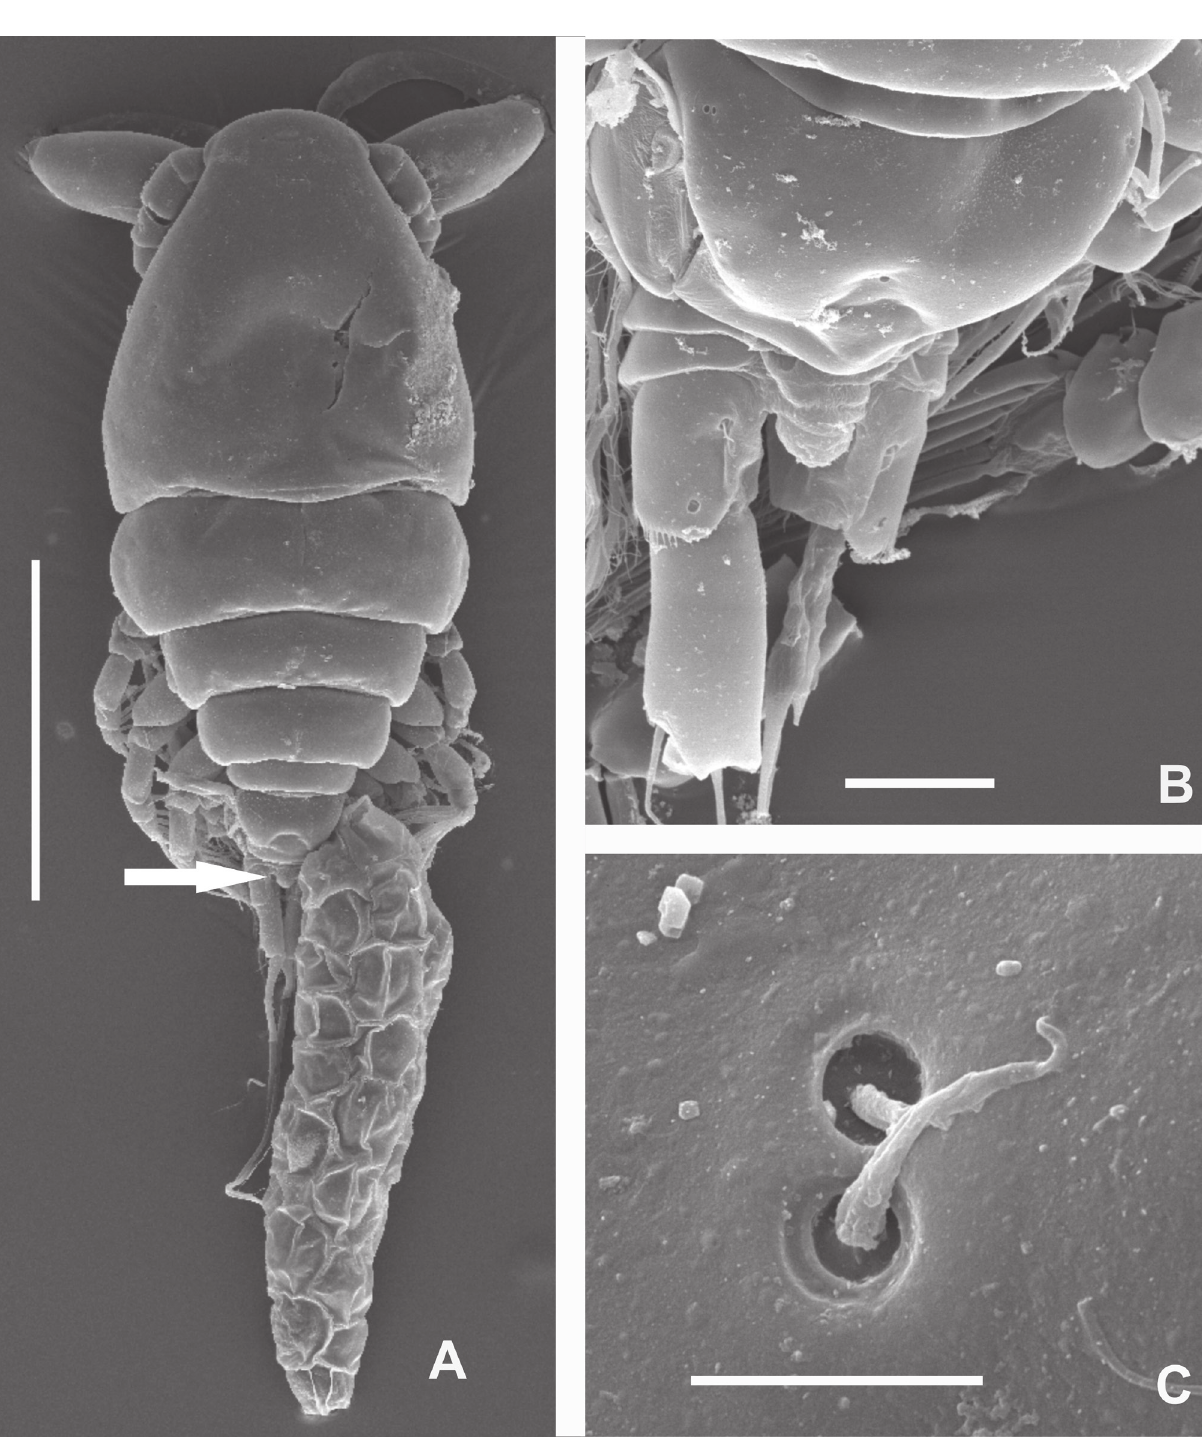
Figure 2. Scanning electron microscopy of Ergasilus turkayi n. sp., adult female. A, Dorsal view, arrow pointing the U-shaped dorsal pseudoperculum in the anal somite; B, closer dorsal view of the pseudoperculum; C, multiple small sensilla distributed along the entire body. Scale bars: A, 200 µm; B, 20 µm; C, 5